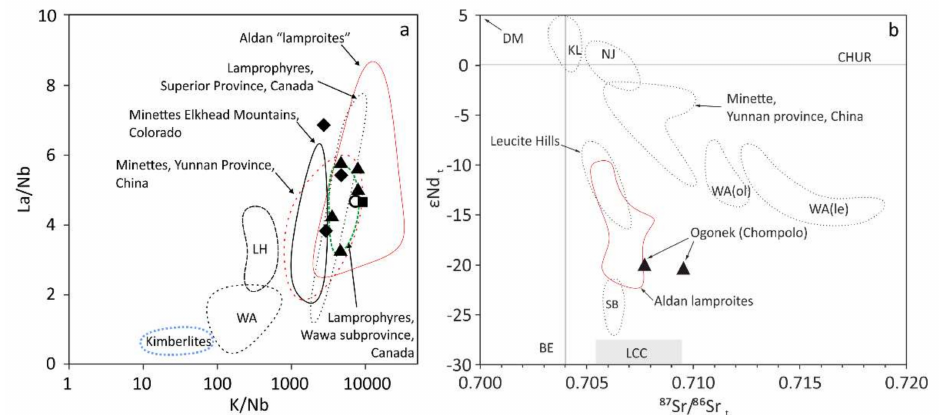
Figure 10. Variations in K / Nb versus La / Nb for Chompolo rocks ( a ) and ε Nd vs. 87 Sr / 86 Sr for lamproite (lamprophyre) occurrences of Aldan shield with new data for the Chompolo alkaline rocks ( b ). For comparison, the fields for kimberlites, lamproites and lamprophyres are given. Abbreviations correspond with kimberlites (KL), Western Australia olivine WA (ol) and leucite WA (le) lamproites, Leucite Hills lamproites (LH), Navajo volcanic field (NJ), Smoky Butte (SB). Description for symbols given in Figure 8. Data sources for ( b ):